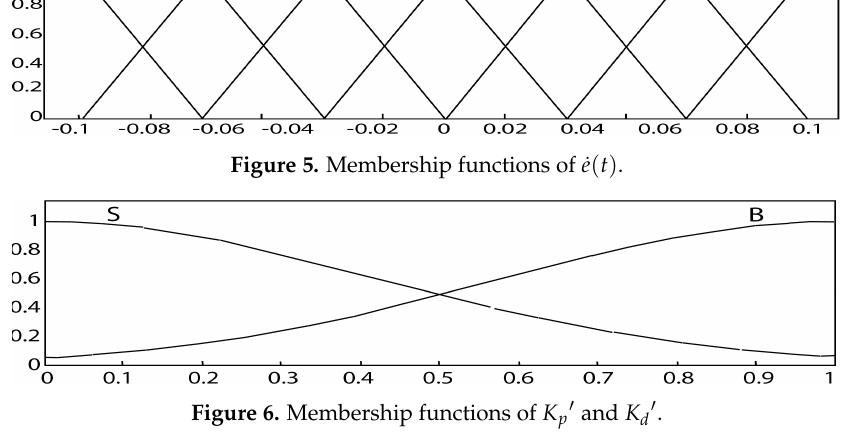
Figure 6. Membership functions of K p (cid:48) and K d (cid:48) .